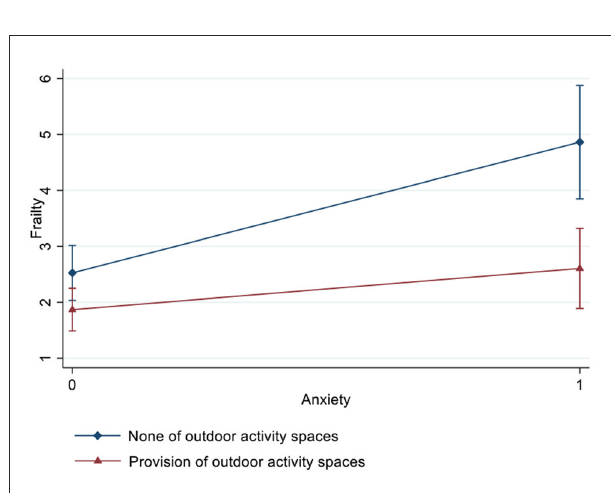
FIGURE3 Interaction effect of anxiety and outdoor activity spaces on frailty among women estimated based on a fully adjusted model (including age, years of education, marital status, economic conditions, comorbidities, cognitive impairment, loneliness, and nutritional status).